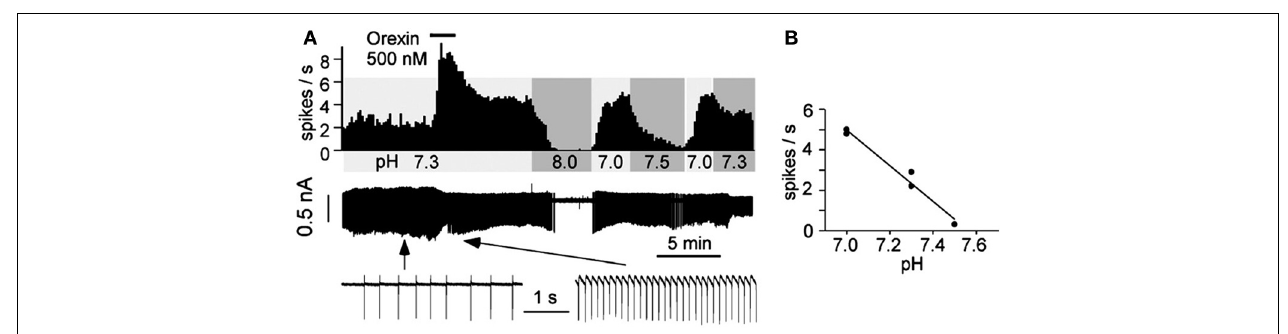
FIGURE 9 | Orexin A excites acid sensitive eGFP/Phox2b-expressing RTN neurons in vitro . Electrophysiological recordings in slices from neonatal (P6-P10) Phox2b-eGFP mice show that OX-A excited eGFP-expressing RTN neurons in a dose-related manner (A) . The